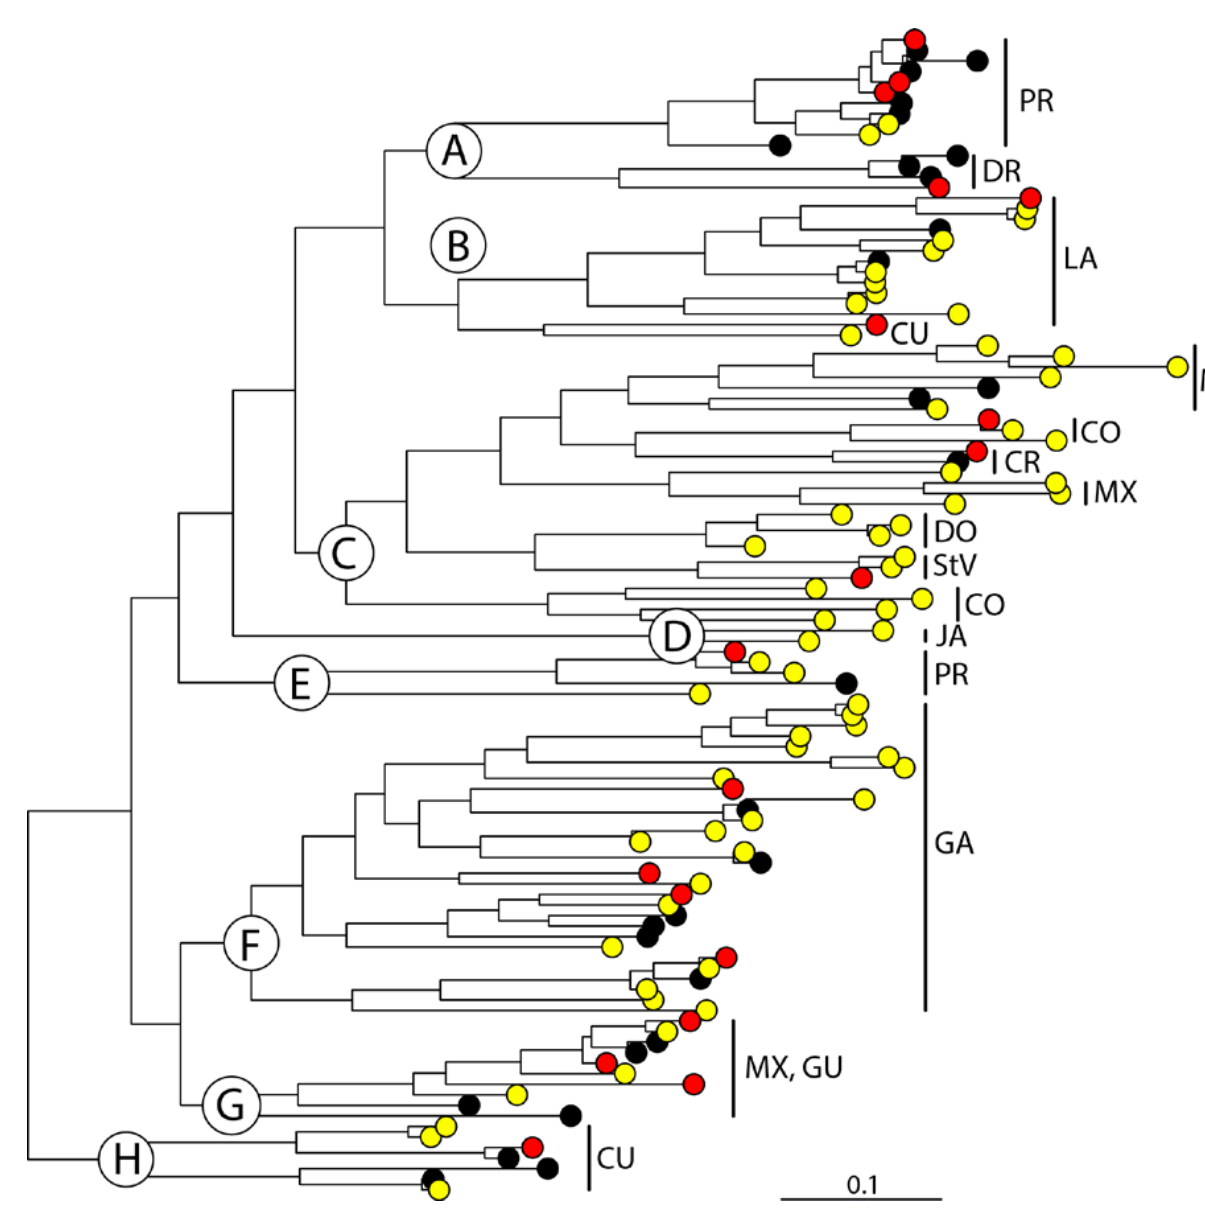
Figure 3. Results of phylogenetic analyses showing a single individual from each of the 110 putative species for the PTP analyses. Letters on nodes indicate eight subclades that are detailed in Figures 3–5, Figures S2–S5, and Table S1. Colored circles indicate the habitat of each sampled species; yellow = epigean, black = cave, and red = both. Lines and abbreviations refer to area of origin: